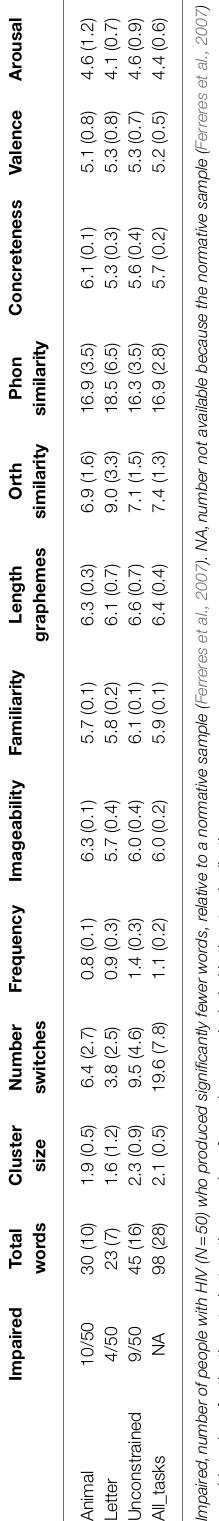
Animal Fluency The random forests regression model, computed to select variables ranking high in importance, explained 59% of variance in the dependent measure total number of words ( R 2 = 0.588; RMSE = 6.13; MAE = 4.49) after leave-one-out cross-validation.